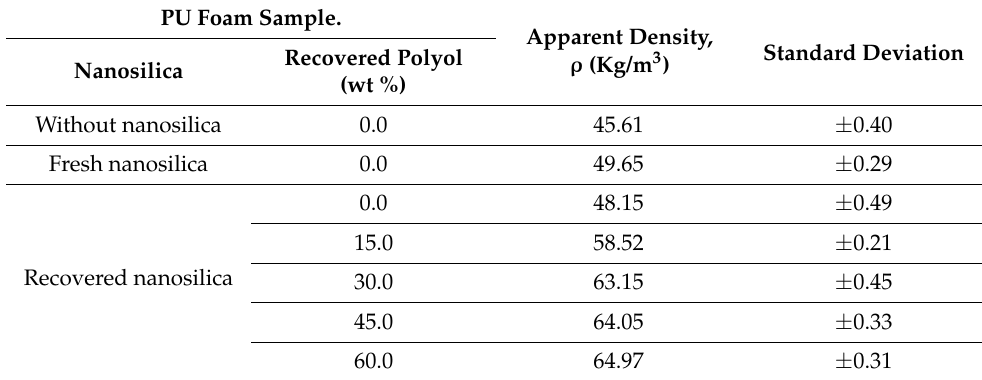
Table 5. Apparent density as a function of the recovered polyol percentage replacing the raw rigid polyol and employing fresh or recovered